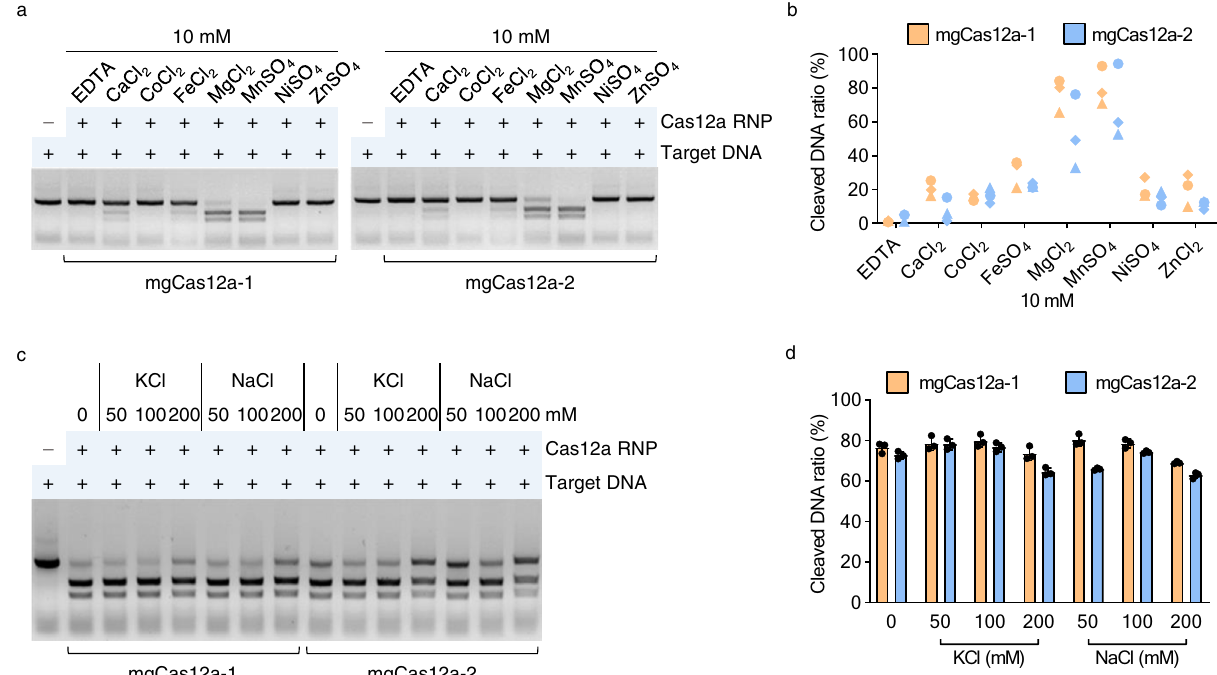
Figure 3. In vitro characterization of the mgCas12a variants in metal ion and salt variations. ( a ) Metal ion- dependent in vitro DNA cleavage activity. 10 mM of EDTA, CaCl 2 , CoCl 2 , FeCl 2 , MgCl 2 , MnSO 4 , NiSO 4 and ZnSO 4 were used as cofactors for target DNA cleavage. Original gels are presented in Supplementary Fig. 4. ( b ) The metal ion-dependent cleavage efficiency of mgCas12a was measured with the assay shown in panel (A) and Supplementary Fig. 4. Three different target DNAs were used. Circle: Target DNA #1; Diamond: Target DNA #2; Triangle: Target DNA #3 ( n = 1 for each target DNA). ( c ) Salt-dependent in vitro DNA cleavage activity. Cleavage assays under a gradient of KCl and NaCl from 50 to 200 mM were performed using target DNA #1. Original gels are presented in Supplementary Fig. 5. ( d ) The cleavage efficiency of mgCas12a under different salt concentrations was measured with the assay shown in panel (C) and Supplementary Fig. 5. The error bars represent standard deviations ( n =